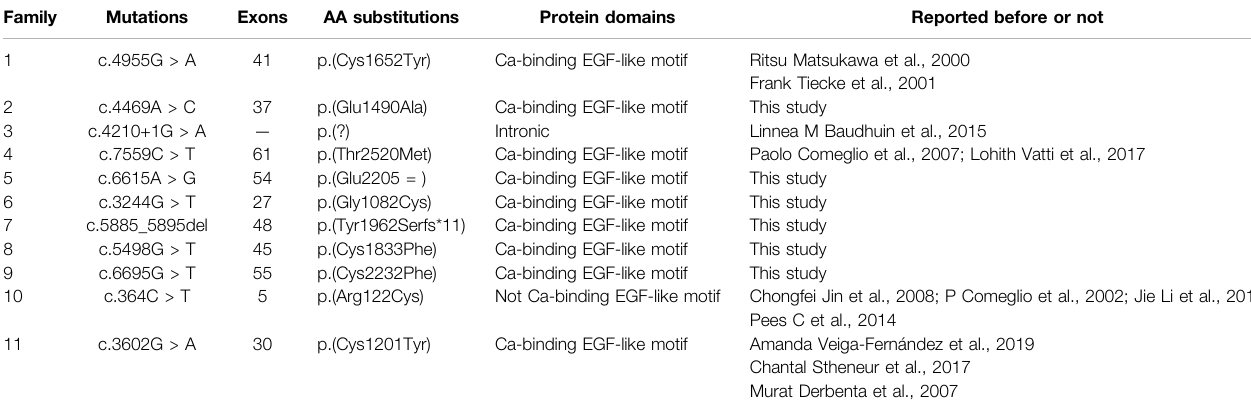
TABLE 2 | FBN1 variants identi fi ed for affected individuals in 11 Marfan